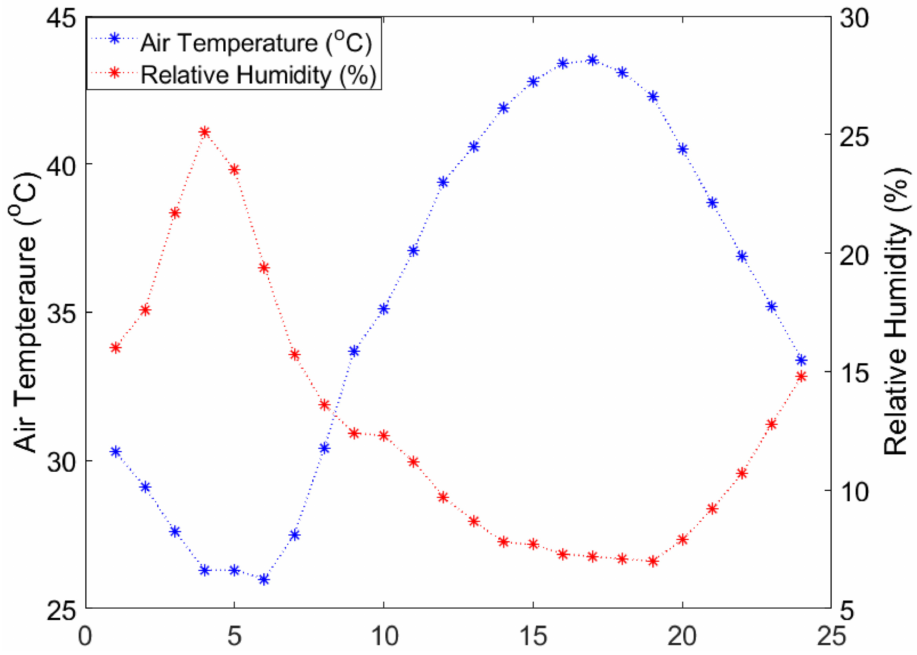
Figure 2. ENVI-met weather input (hourly) for 23 June